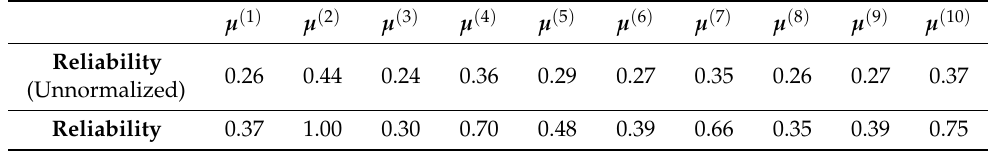
Table 3. The reliabilities of the fuzzy